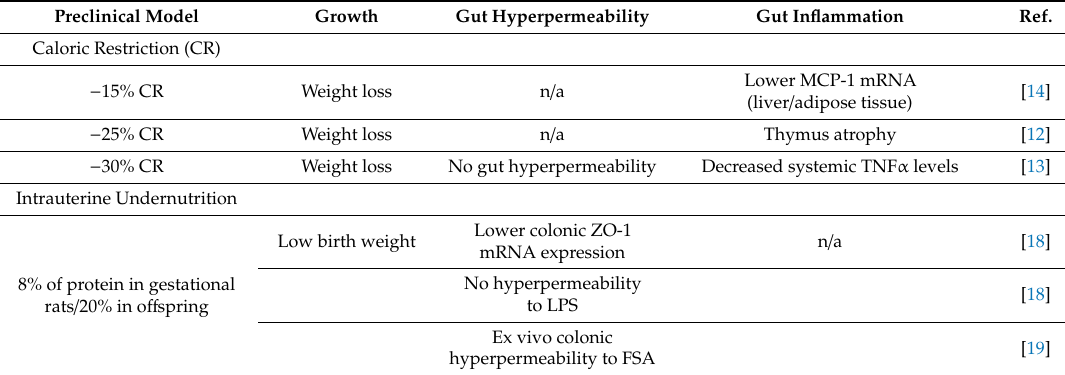
Table 1. Diet modifications and microbiota transfer: e ff ects on growth and environmental enteric dysfunction (EED)